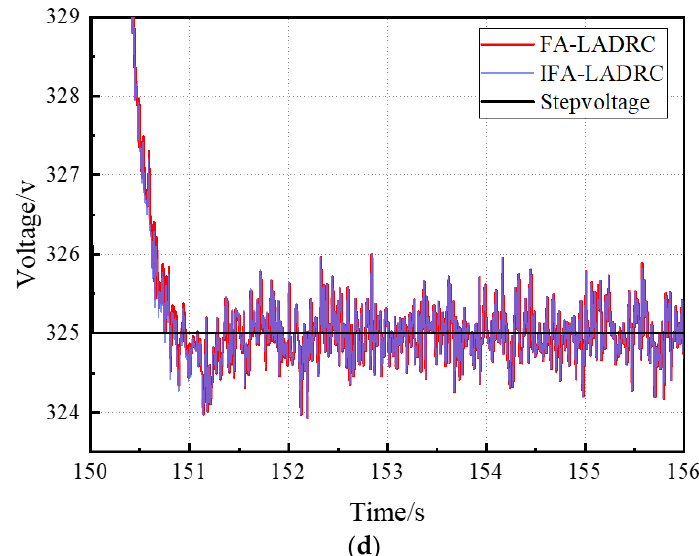
Figure 9. Magnification of the stepup and stepdown response curves of two controllers. ( a ) PID controller boost response curves. ( b ) PID controller buck response curves. ( c ) LADRC controller boost response curves. ( d ) LADRC controller buck response curves.